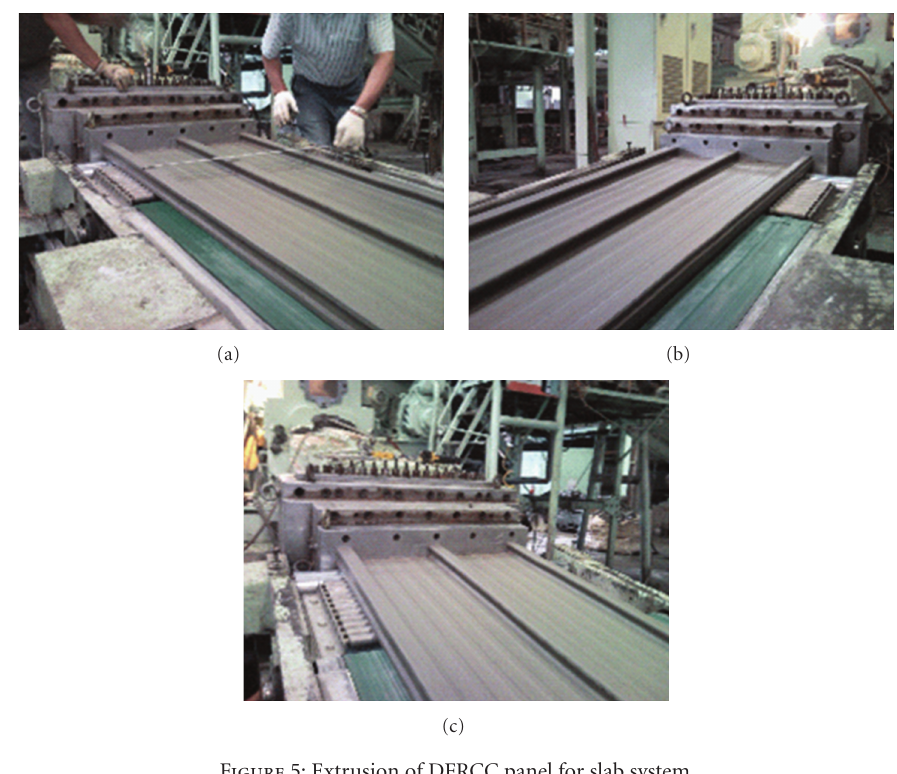
Figure 5: Extrusion of DFRCC panel for slab system.